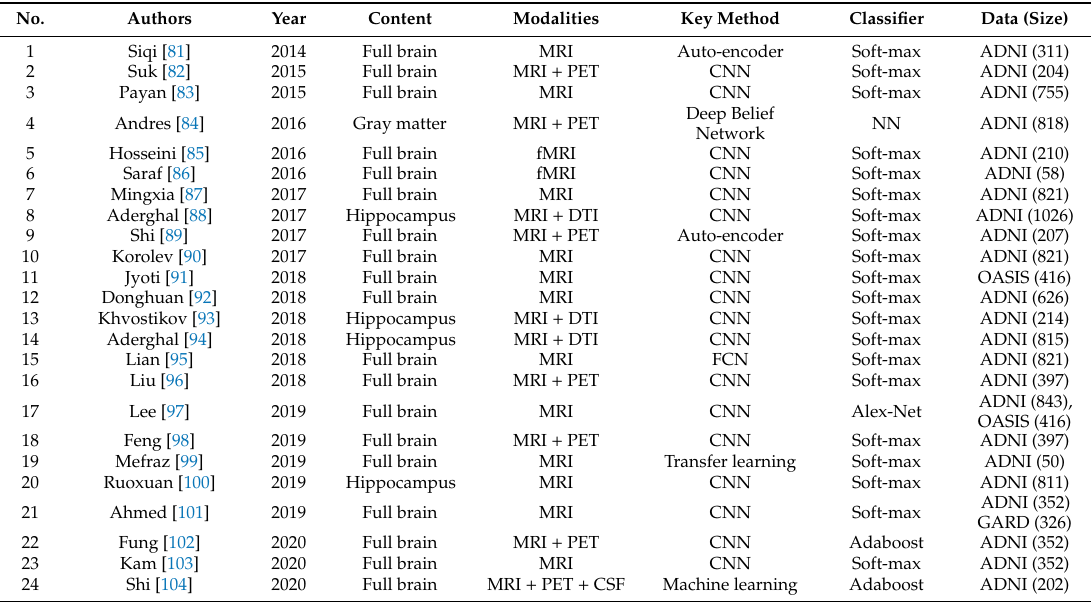
Table 5. Comparison of the state-of-the-art methods in the field of AD diagnosis. No.